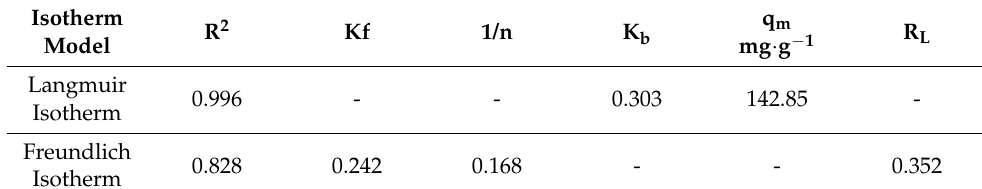
Table 4. Adsorption isotherm models, for adsorption Cr (VI) on M-AC composite.